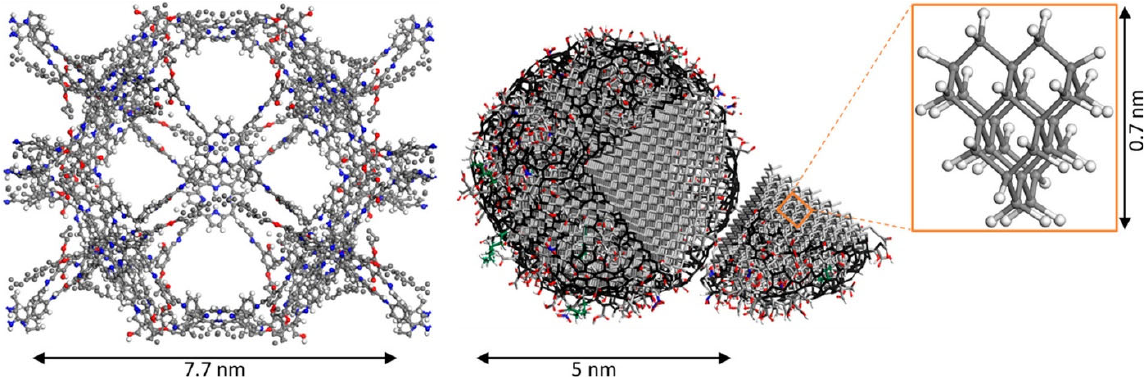
Figure 6. Optimized atomistic models: (left) one of the largest synthesized molecules, 7.7 nm tetracosakis([2 ‐ hydroxy ‐ 5 ‐ (octyloxy) ‐ 1,3 ‐ phenylene]dimethylidene)dodecakis(5,10,15,20 ‐ tetrakis(4 ‐ 7.7 nm tetracosakis([2-hydroxy-5-(octyloxy)-1,3-phenylene]dimethylidene)dodecakis(5,10,15,20- aminophenyl)porphyrin), C 912 H 841 N 96 O 48 ; (middle) 5 nm DND with diamond core structure and tetrakis(4-aminophenyl)porphyrin), C 912 H 841 N 96 O 48 ; ( middle ) 5 nm DND with diamond core struc- different types of functional groups and sp 2 C on the surface; (right) [1(2,3)4]pentamantane, C 26 H 32 , ture and different types of functional groups and sp 2 C on the surface; ( right ) [1(2,3)4]pentamantane, a representative diamondoid [51]. C 26 H 32 , a representative diamondoid